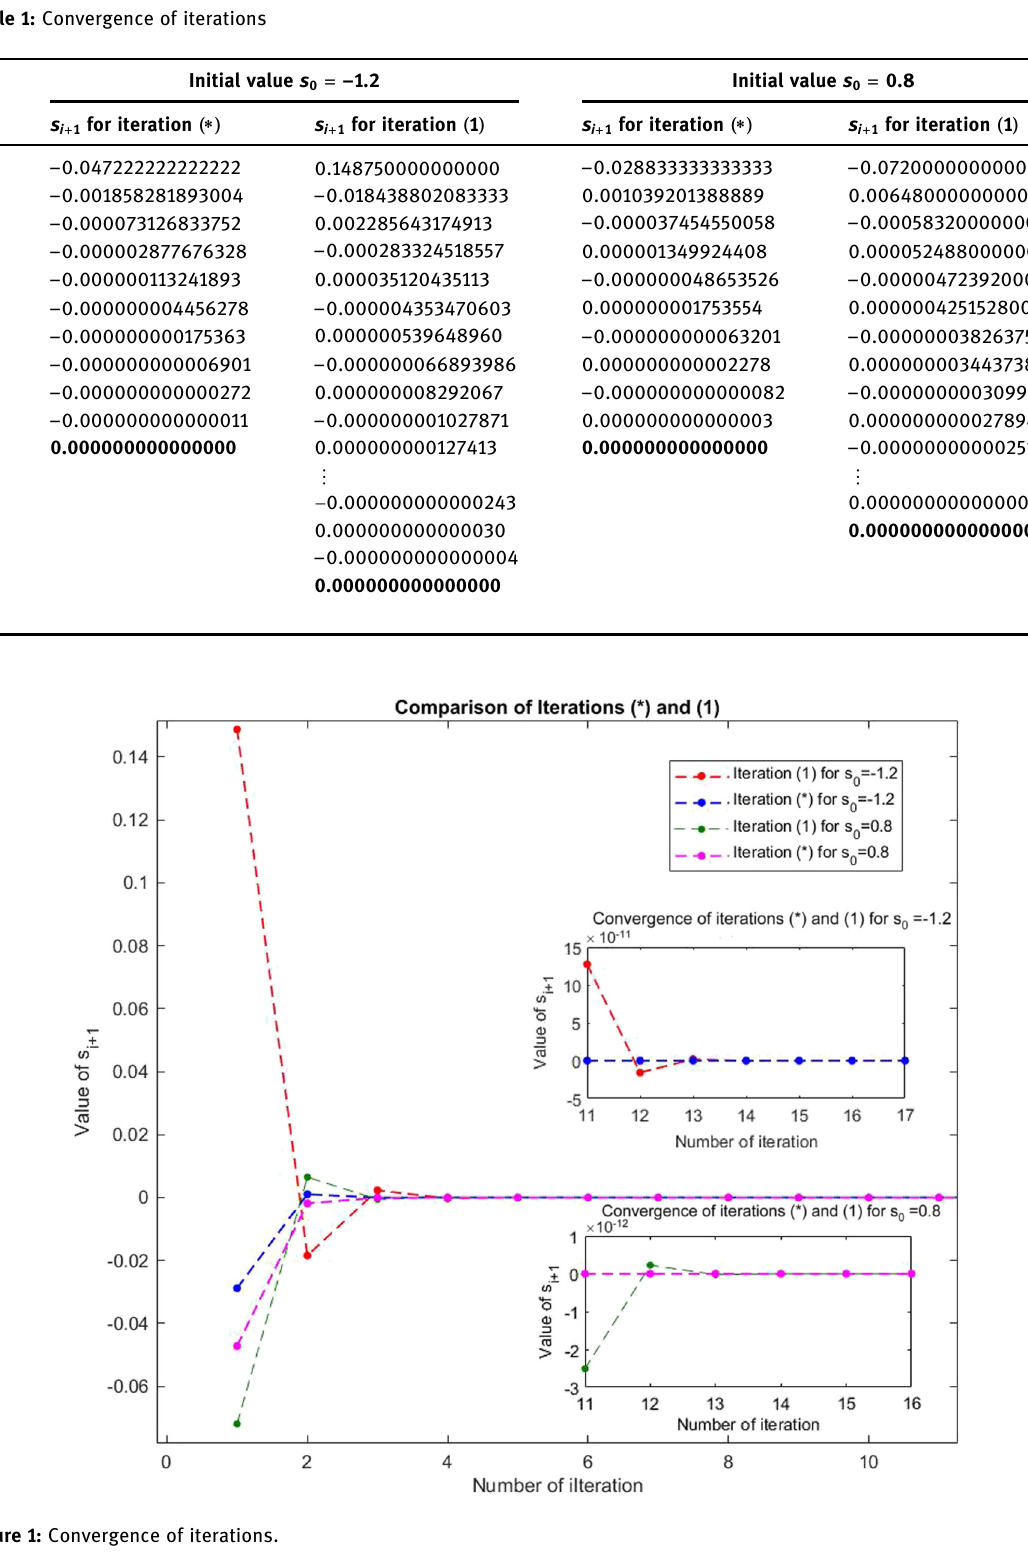
Figure 1: Convergence of